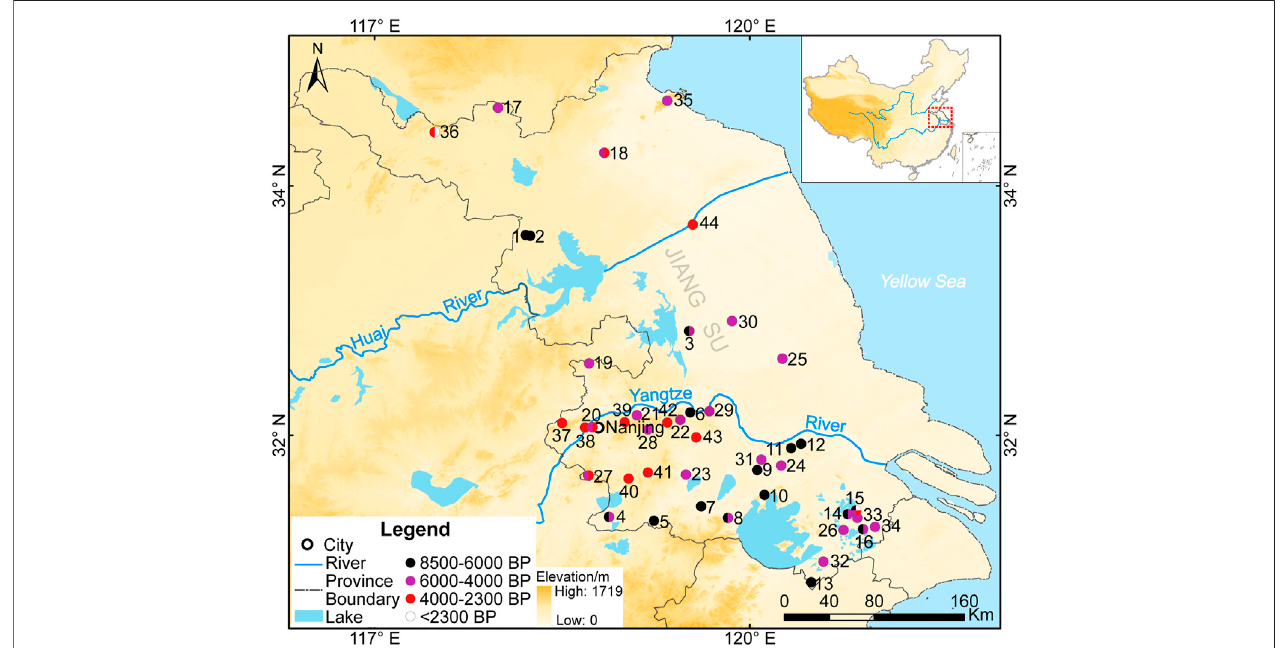
FIGURE 1 | Map of Jiangsu and sites mentioned in this study. 1) Shunshanji; 2) Hanjing; 3) Longqiuzhuang; 4) Xuecheng; 5) Shendun; 6) Zuohu; 7) Xixi; 8) Luotuodun; 9) Weidun; 10) Yangjia; 11) Qitoushan; 12) Dongshancun; 13) Guangfucun; 14) Caoxieshan; 15) Chuodun; 16) Jiangli; 17) Dadunzi; 18) Wanbei;